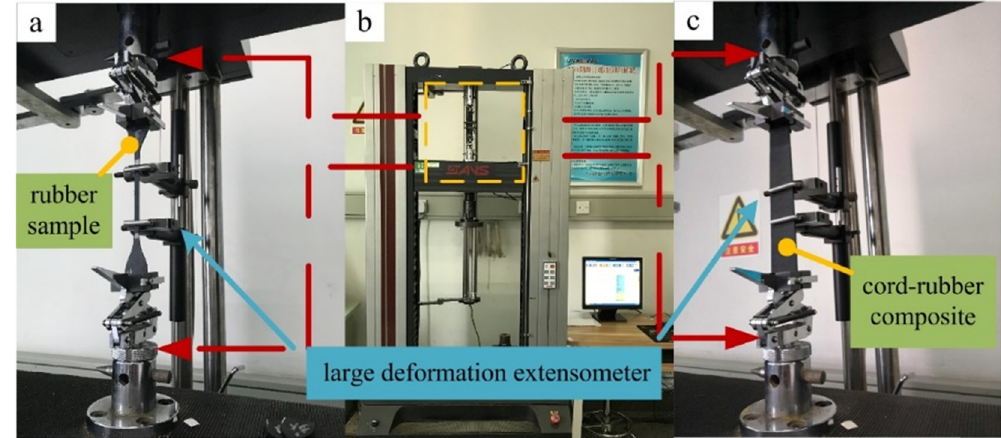
Figure 3: ( a ) Rubber tensile test, ( b ) tensile testing machine, and ( c ) cord – rubber composite tensile